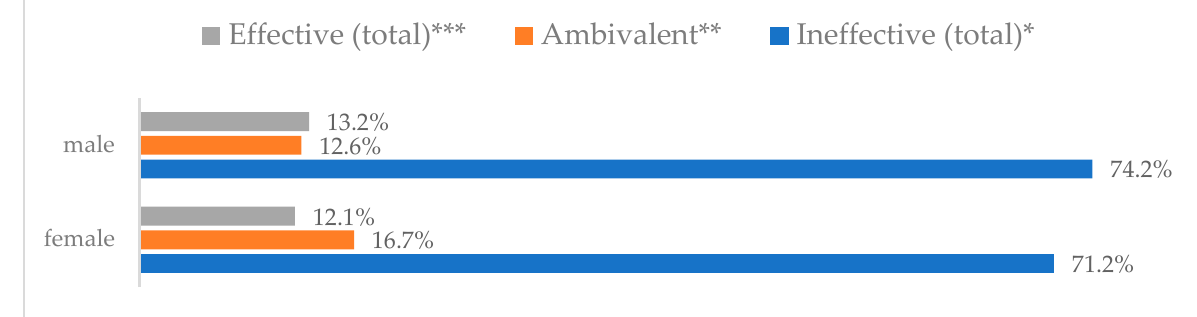
*Sum of responses: completely ineffective, ineffective, rather ineffective; **Response: neither inef- * Sum of responses: completely ineffective, ineffective, rather ineffective; ** Response: neither